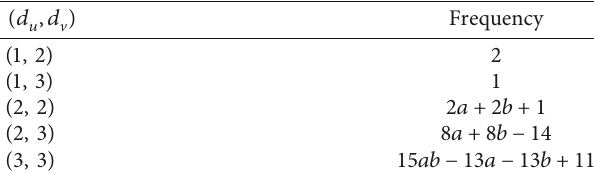
Table 4: NGHI and parameters of regression models.